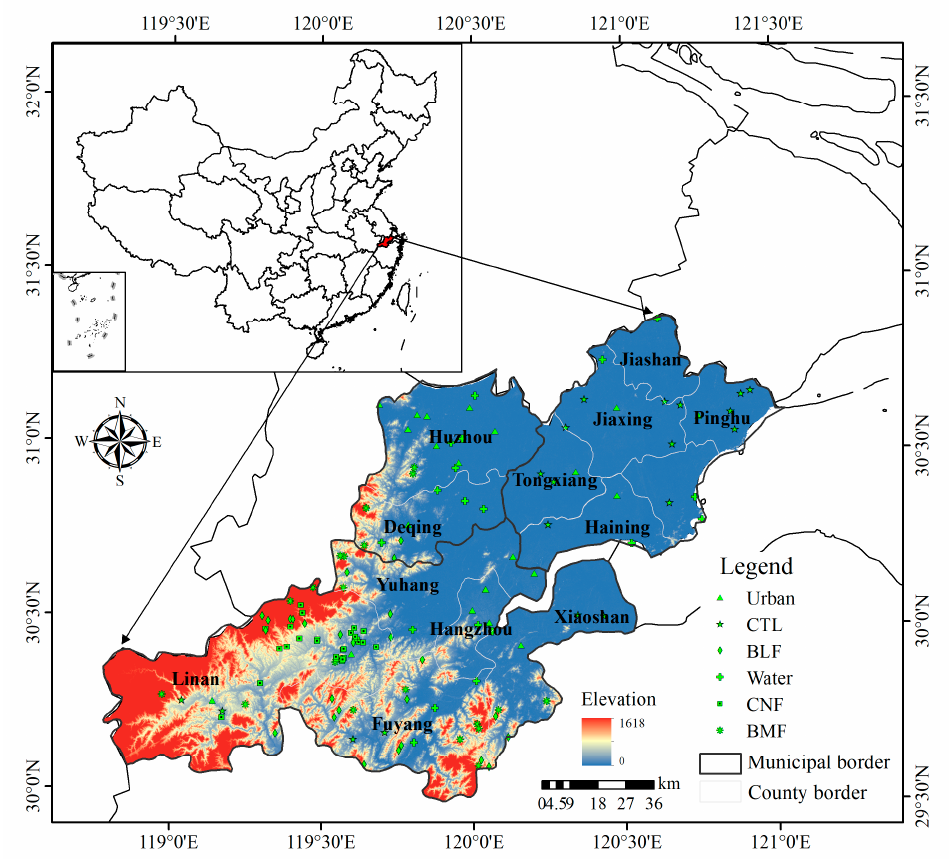
Figure 1. Study area and ground survey plots of 2015.